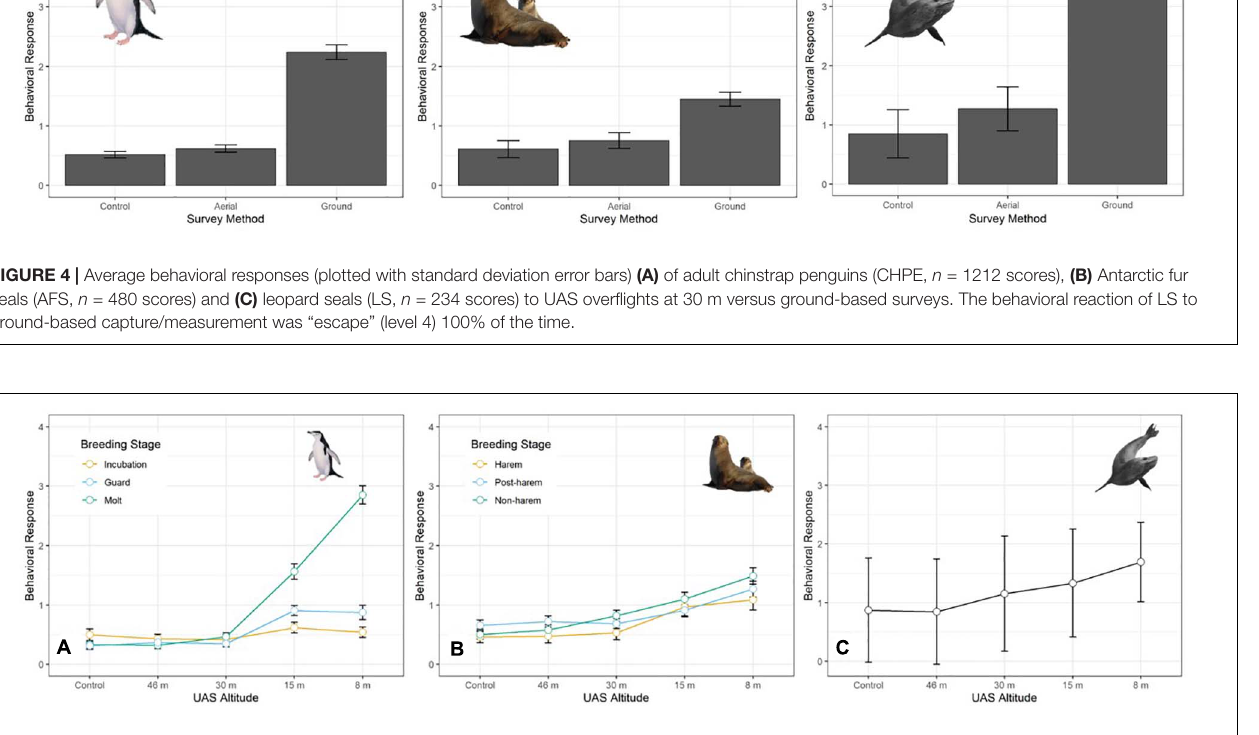
FIGURE 5 | Average behavioral responses (plotted with standard deviation error bars) of (A) adult chinstrap penguins (CHPE, n = 3,597 scores), (B) Antarctic fur seals (AFS, n = 4,254 scores) during early, mid-, and late stages of their summer breeding chronologies, and (C) and leopard seals (LS, n = 387 scores) to unoccupied aerial systems (UAS) overflights at specific altitudes.